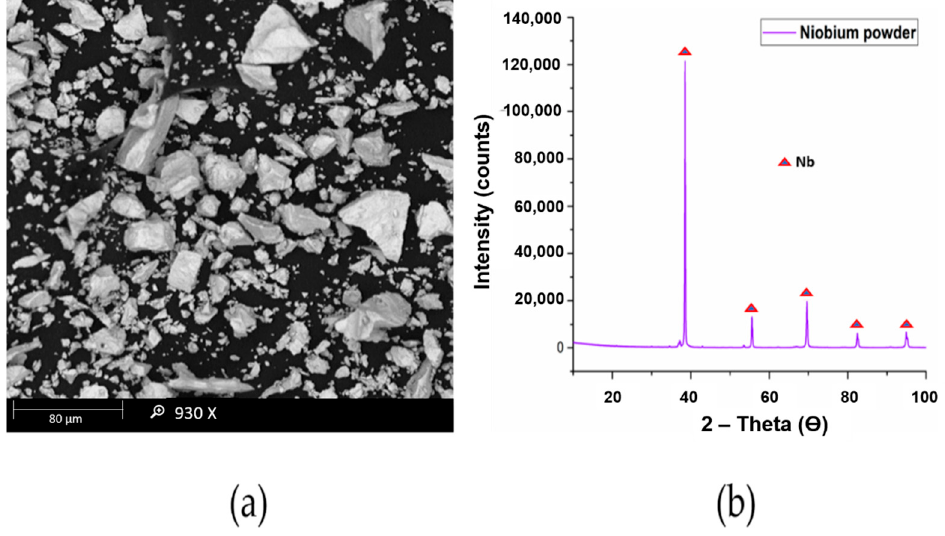
Figure 3. ( a ) SEM ( b ) XRD analysis of niobium powder.